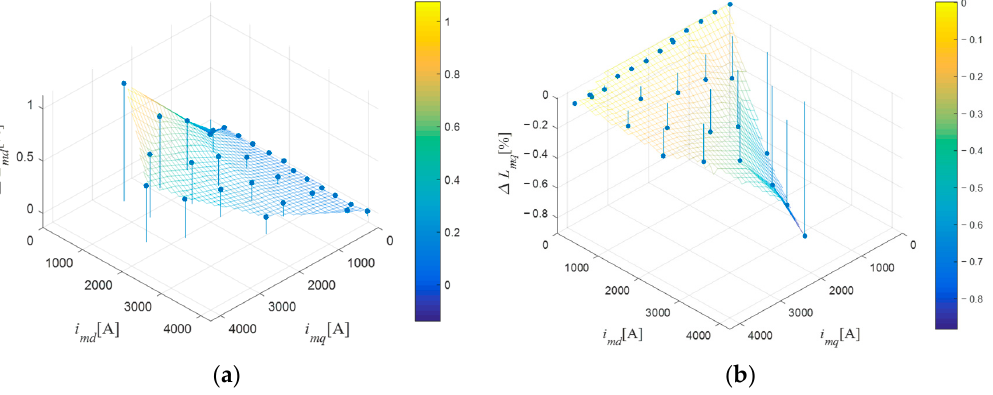
Figure 12. Percentage change of the obtained magnetizing inductances due to a 50% increase in stator resistance: ( a ) d -axis magnetizing inductance; ( b ) q -axis magnetizing inductance.